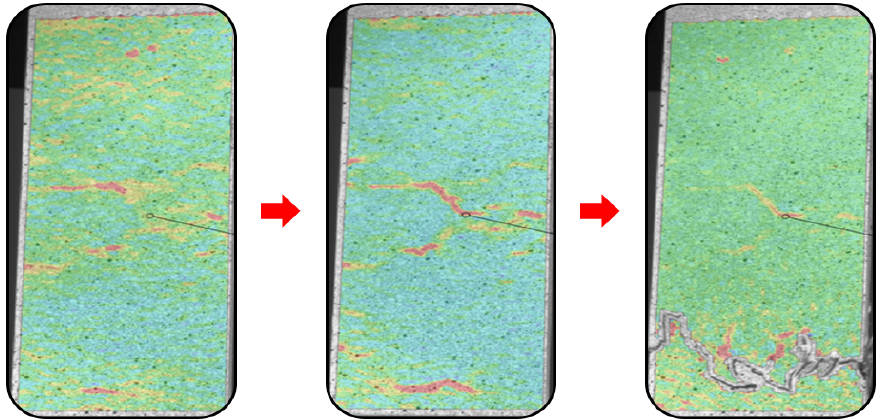
Figure 19. Confirmation of the crack initiation using digital image correlation (DIC) during the fatigue test.